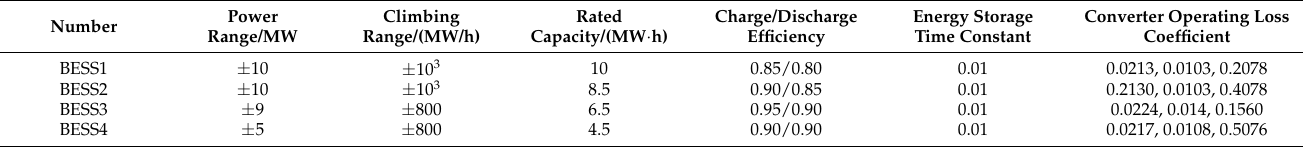
Table 2. Basic parameters of the distributed BESS.